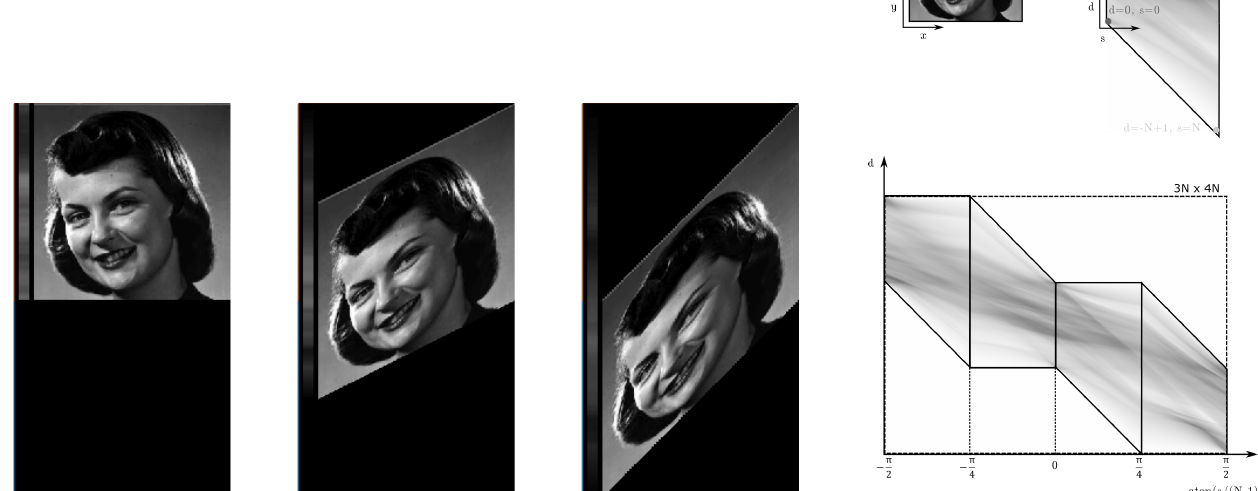
Figure 1. First three subfigures: from left to right, an image sheared to accommodate, in a row, the discrete lines of conventional DRT for minimal, intermediate, and maximal slope of the 0 to 45 degrees quadrant. Rightmost, a depiction of input and output of conventional DRT for a single quadrant. Additionally, the shape of the output of 4 quadrants, joined together within a 3 N × 4 N rectangular memory footprint, where half of the space is